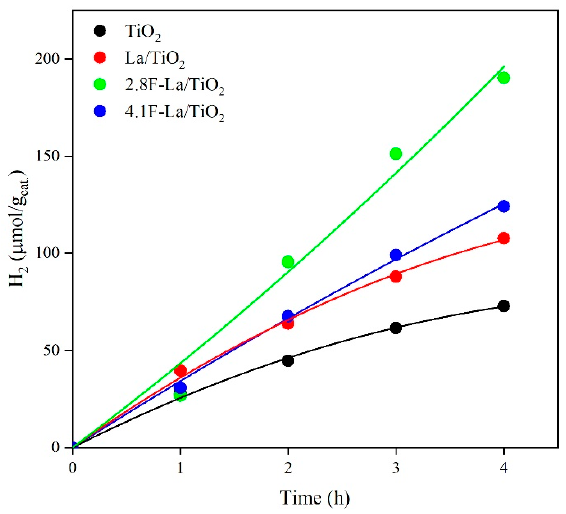
Figure 6. Generation of hydrogen in the photocatalytic degradation of methanol-water solution in the presence of the investigated photocatalysts.